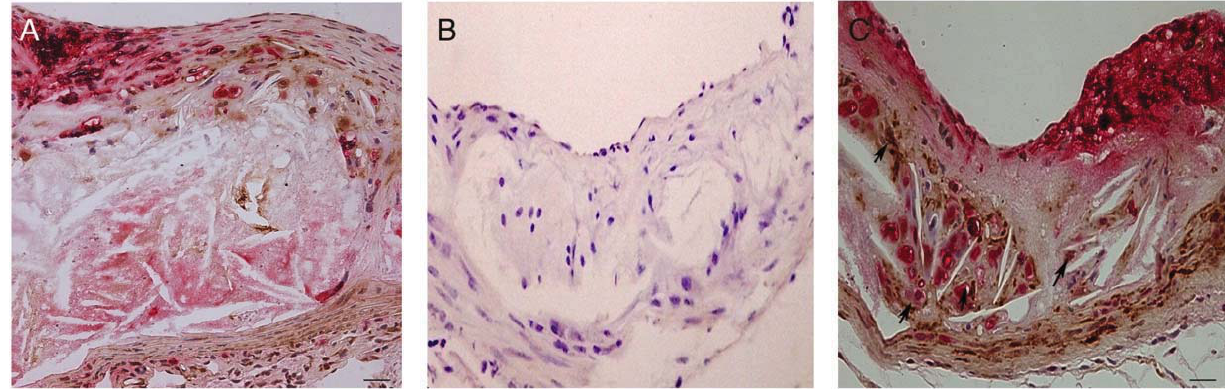
Figure 4. Tribbles 3 staining in experimental mouse atherosclerosis. A Dual staining of trb-3 (brown) and macrophages (Gal3); B negative control (secondary Ab only); C dual staining as A to show some coincident trb-3 and macrophage staining to show an equal proportion of trb3 in macrophages and